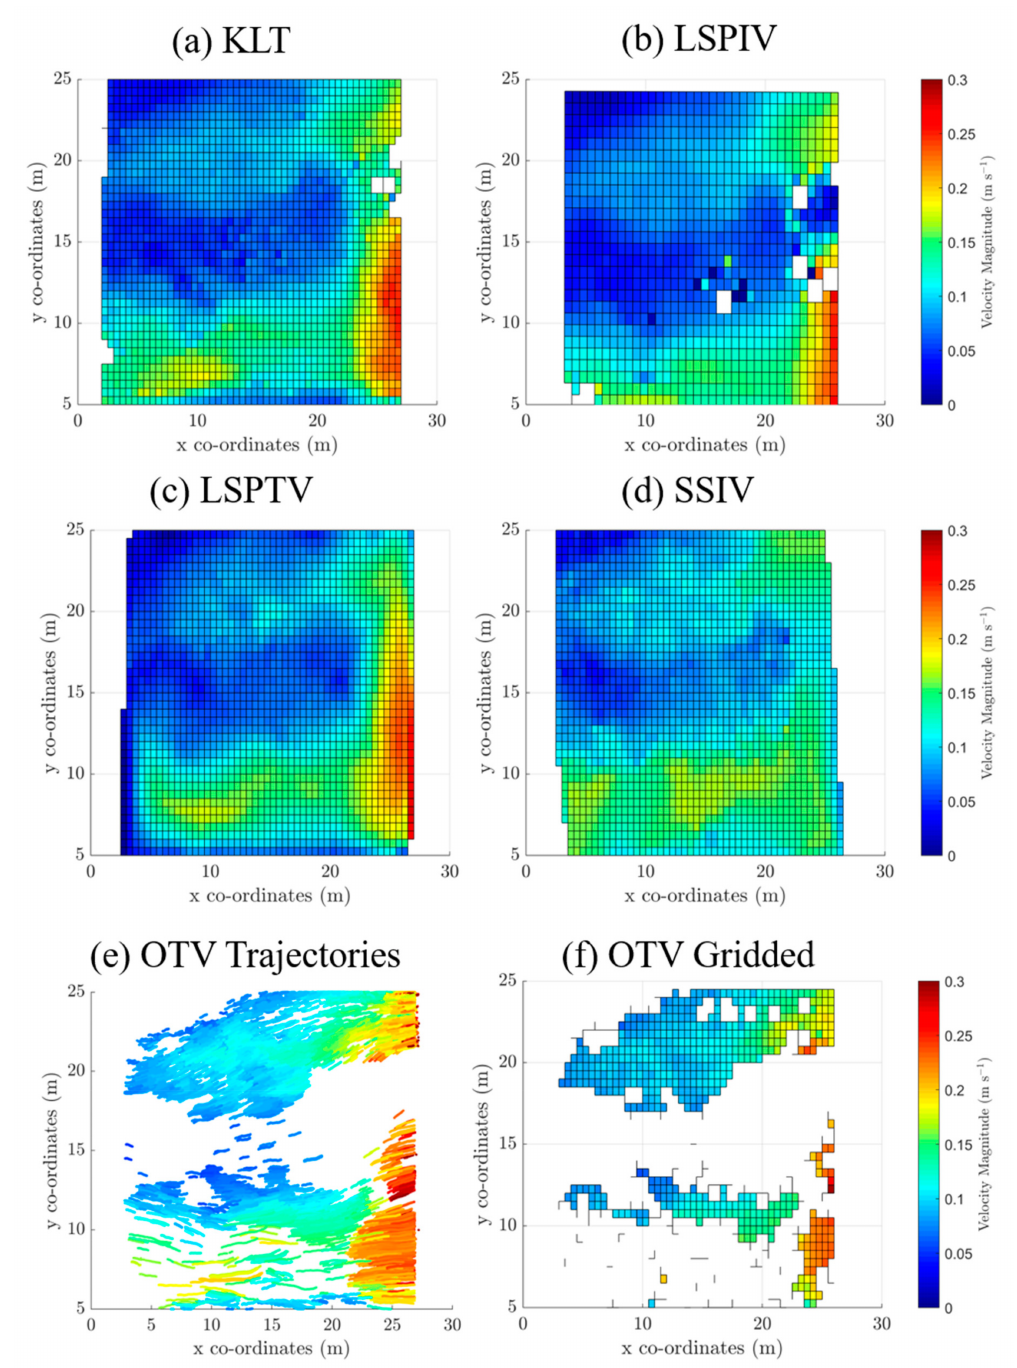
Figure 4. Gridded surface velocity maps for all algorithms, including the original trajectory map for OTV ( e